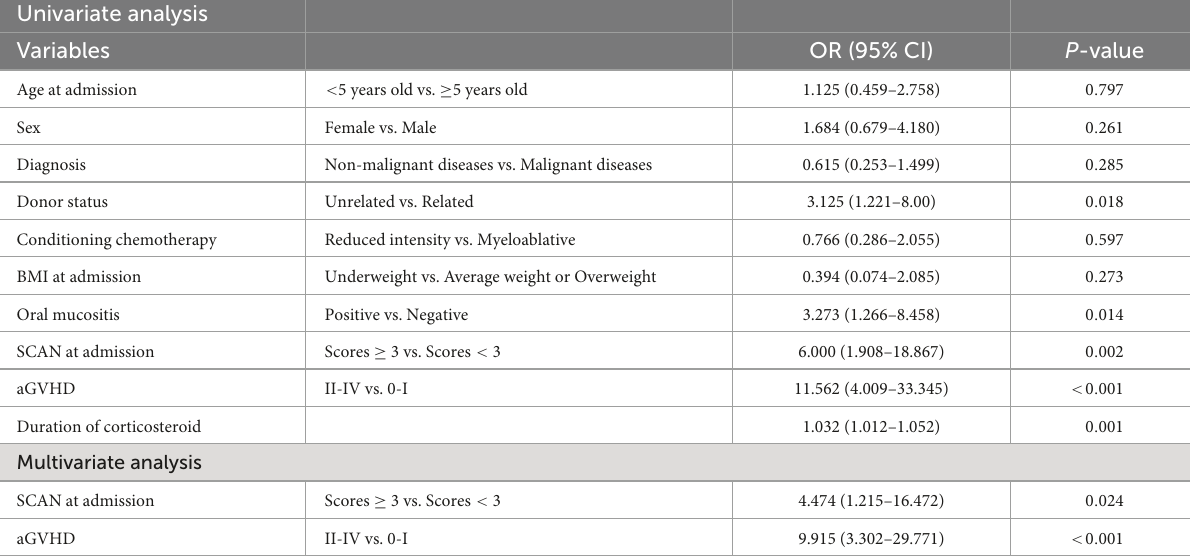
TABLE 2 Results of univariate and multivariate analyses of factors affecting weight loss ≥